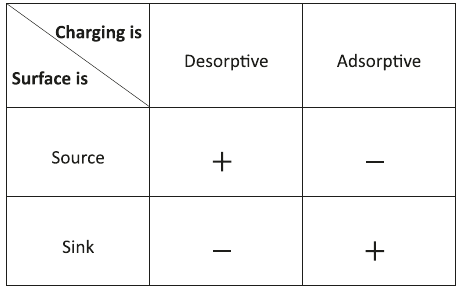
Fig. 8 Overview of charging and dissolution coupling. Indication whether the surface charge increases ( + ) or decreases ( − ) upon fl ow. Column position indicates if the surface is a source or sink of reactive ions, row position indicates if the reactive ion desorbs or adsorbs to generate surface charge. The change of surface charge upon fl ow is always larger at the inlet than at